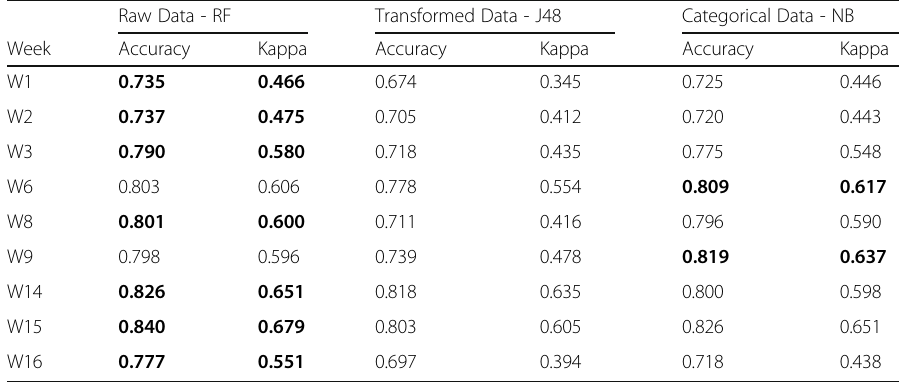
Table 5 Average scores of the models in terms of Accuracy and Kappa Raw Data -